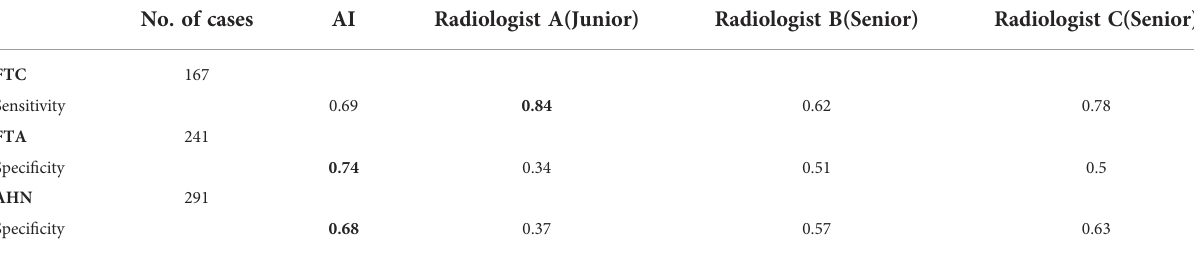
TABLE 3 The respective diagnostic performances of the AI system and three radiologists in diagnosing FTC, FTA and AHN